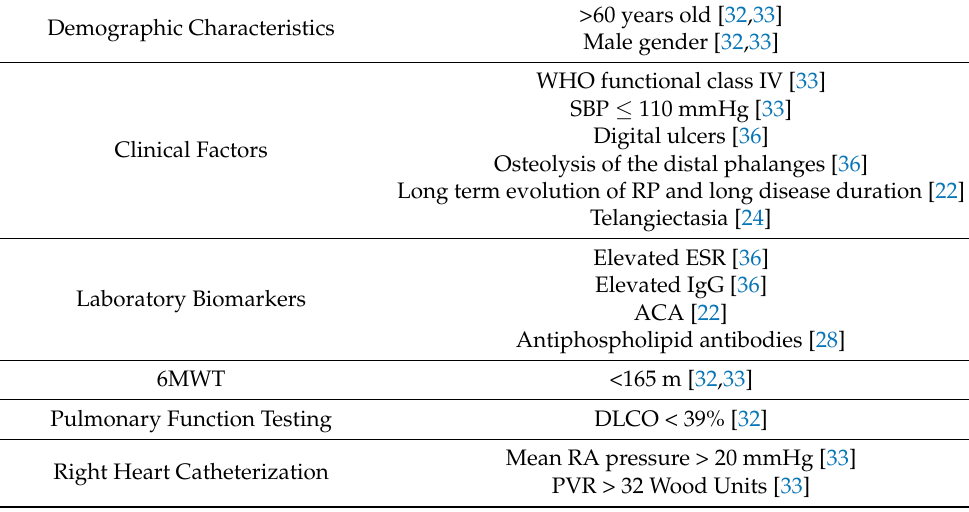
Table 2. Risk factors for PH development in SSc. Legend: WHO–World Health Organization, ESR- erythrocyte sedimentation rate, 6MWT–six-minute walking test, DLCO-diffusing capacity for carbon monoxide, RHC-right heart catheterization, RA–right atrium, SBP–systolic blood pressure, IgG–G immunoglobulins, PVR–pulmonary vascular resistance, W.U.–Wood Units, ACA–anti-centromere antibodies, RP–Raynaud’s